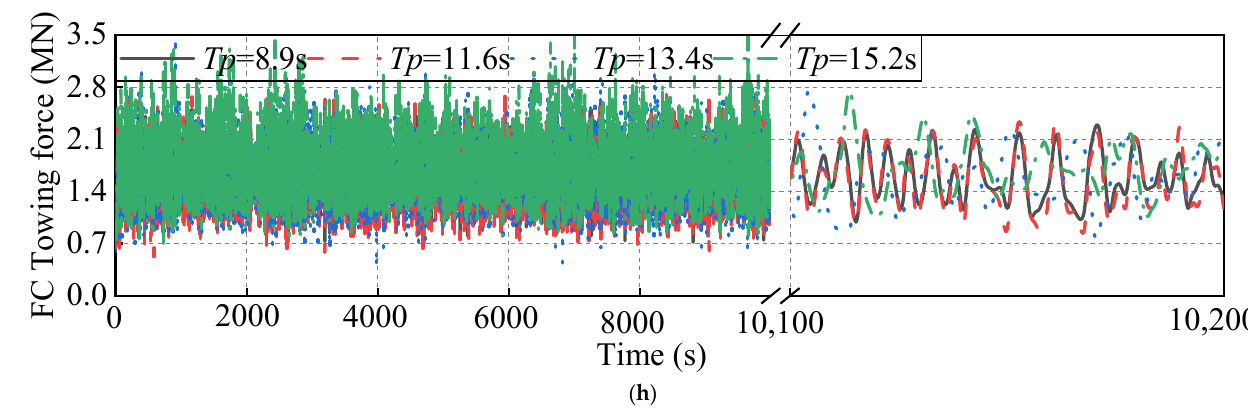
Figure 15. Time series of the SFOWTs under different wave period conditions ( Hs = 5 m). ( a ) Heave motion of TC-SFOWT, ( b ) heave motion of FC-SFOWT, ( c ) pitch motion of TC-SFOWT, ( d ) pitch motion of FC-SFOWT, ( e ) roll motion of TC-SFOWT, ( f ) roll motion of FC-SFOWT, ( g ) towing force of TC-SFOWT, ( h ) towing force of FC-SFOWT.